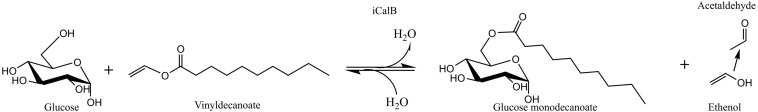
Reaction scheme of enzymatic synthesis of glucose monodecanoate.